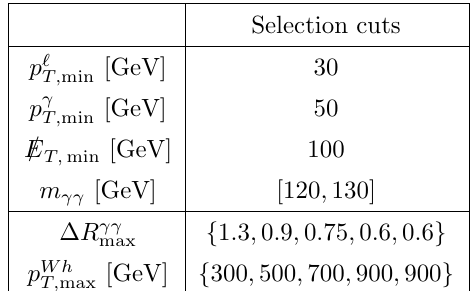
Table 3 . A summary of the selection cuts applied to the Monte Carlo events. The entries for (cid:1) R (cid:13)(cid:13) and p Wh correspond to the cuts performed in each p h max T; max of the